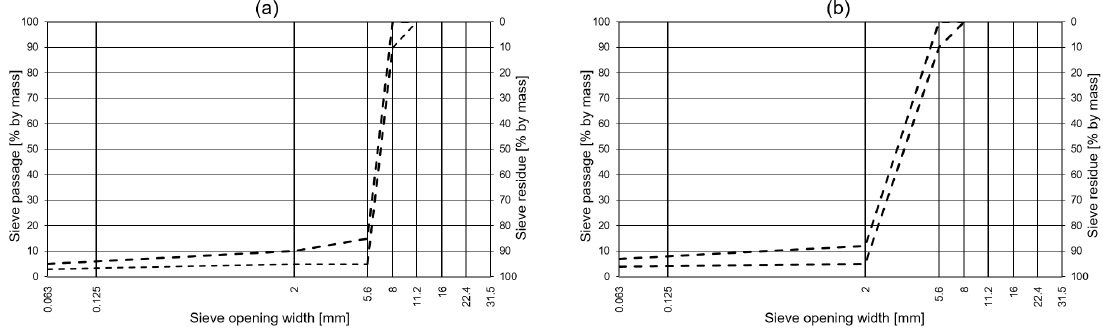
Figure 2. Grading curves according to the German guidelines of Porous Asphalt [20] ( a ) and [21] ( b